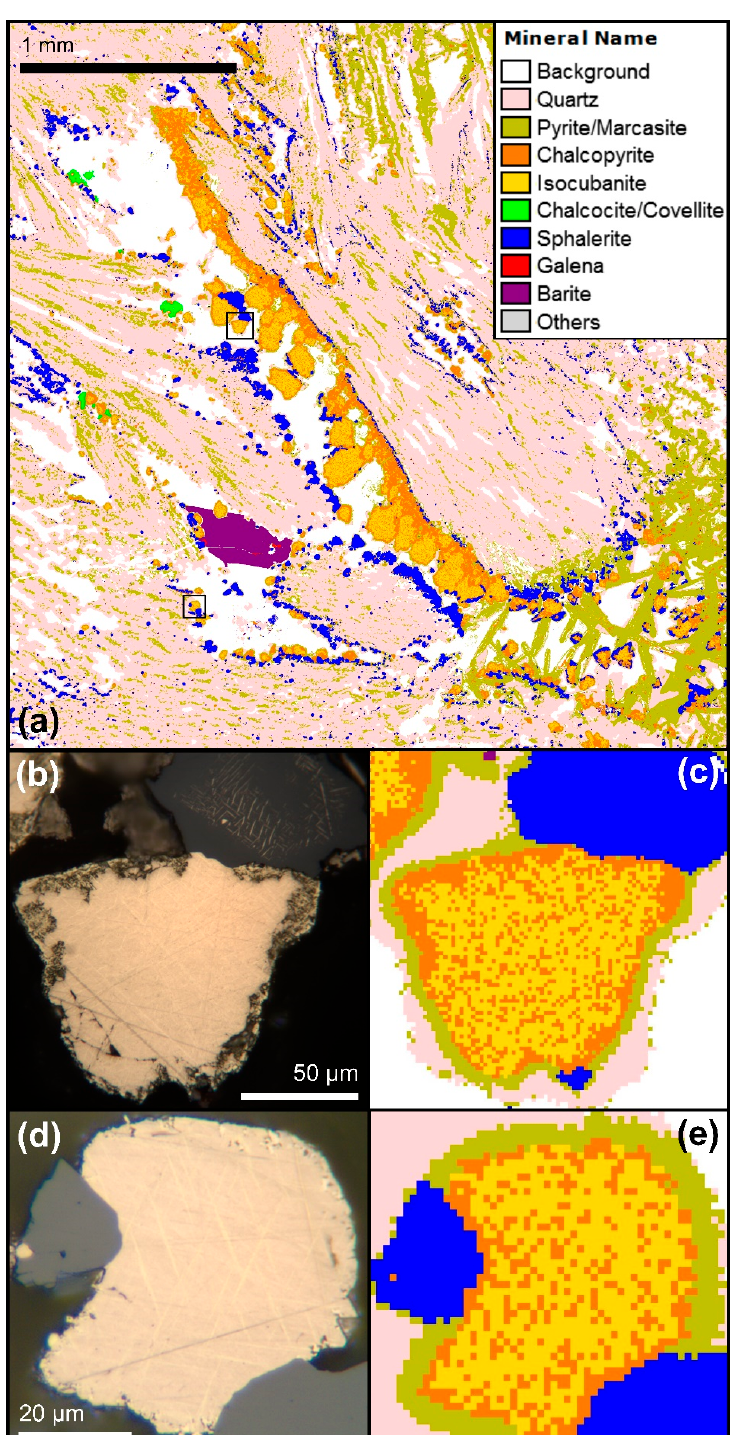
Figure 7. ( a ) False colour QEMSCAN field scan at 1 μ m pixel spacing. Cu–sulphide phases are coarser than sphalerite, and consist of intergrown chalcopyrite and isocubanite. Pyrite occurs as ultrafine disseminations throughout the gangue, and as coarser laths in the upper right; ( b – e ) QEMSCAN cannot properly resolve variations in Cu–Fe–sulphides because the crystallographically controlled exsolution lamellae are smaller than EDS resolution, and chalcopyrite and isocubanite signals become merged. Sub ‐ micron chalcopyrite inclusions in sphalerite ( c ) are missed completely. A well ‐ defined pyrite rim under QEMSCAN is not as apparent in reflected light microscopy.